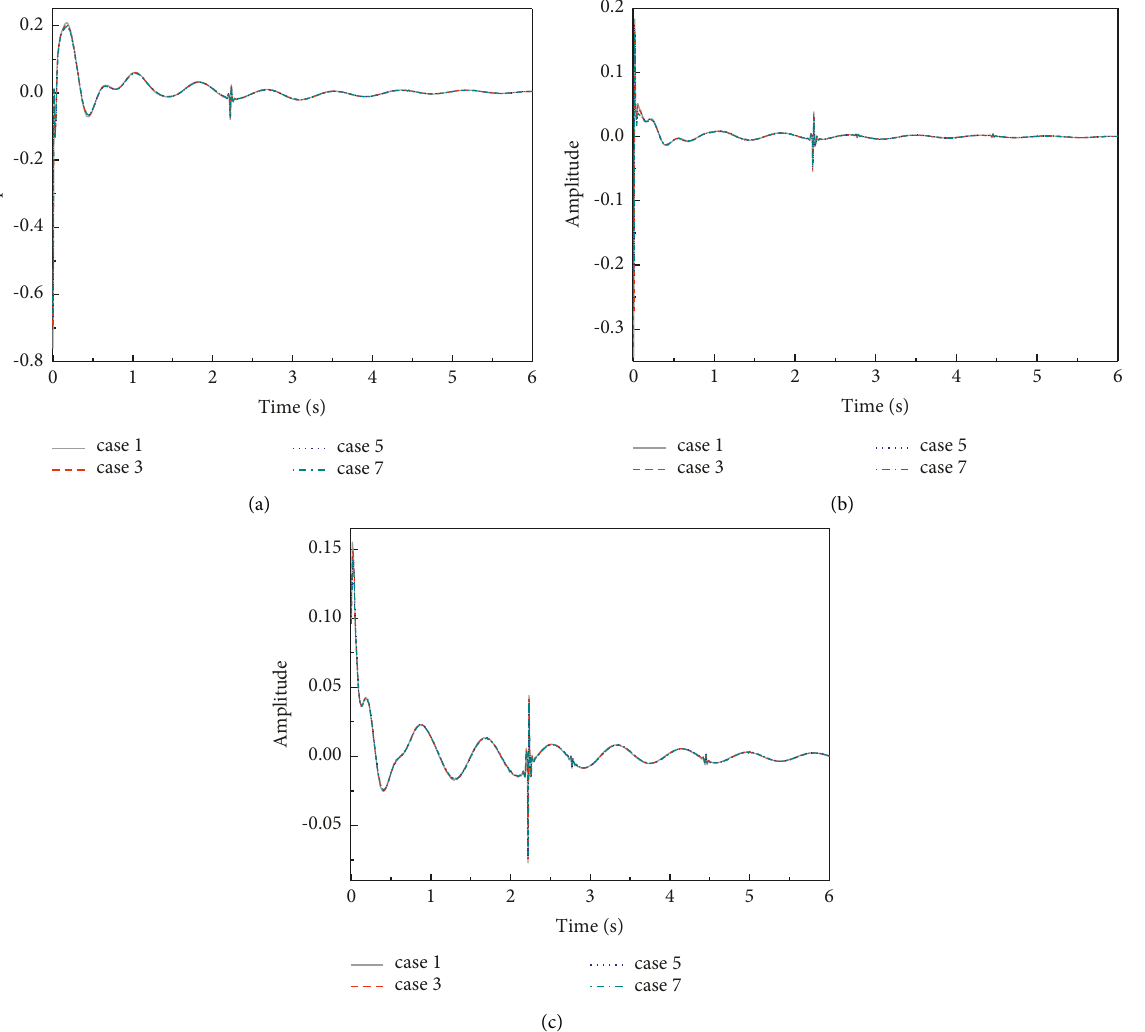
Figure 5: VIRF time history curves of measurement points (the second time test at excitation point II). (a) Point 4. (b) Point 5. (c) Point